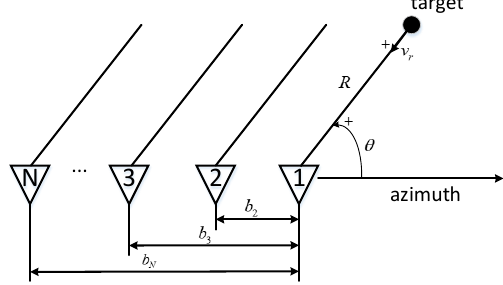
Figure 1. Acquisition geometry using a multichannel